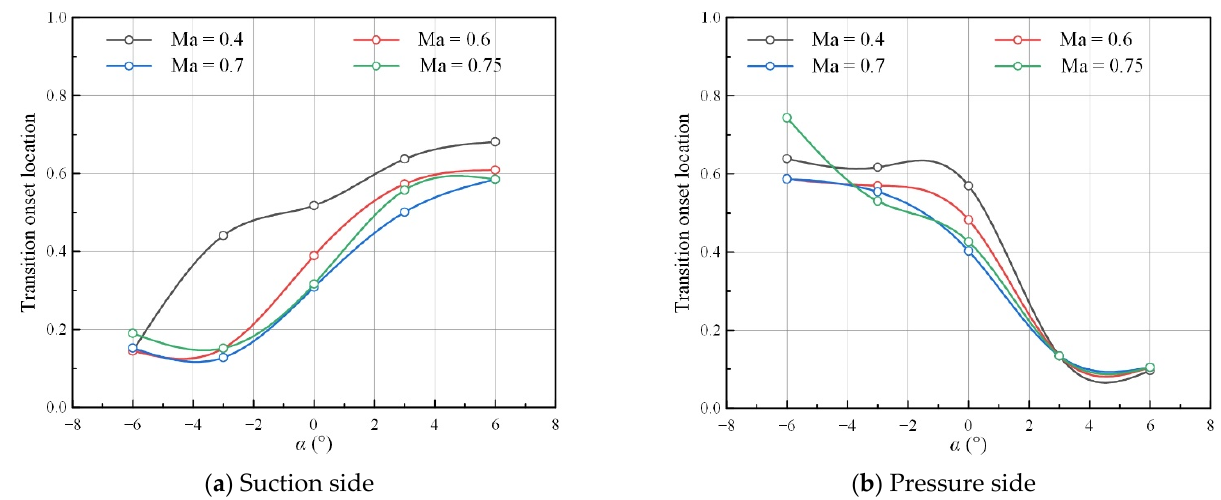
Figure 14. Transition onset locations under various angles of attack ( ε = 0.5%, T w = 293